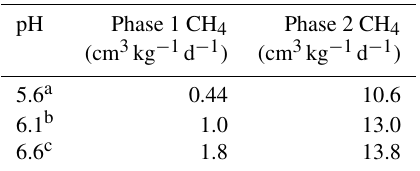
Figure 6. Experiment 3. Concentration of ferrous iron (Fe 2 + ) in the liquid phase with varied pH in microcosms receiving hay in sandy loam. Different letters indicate a difference at p < 0.05.